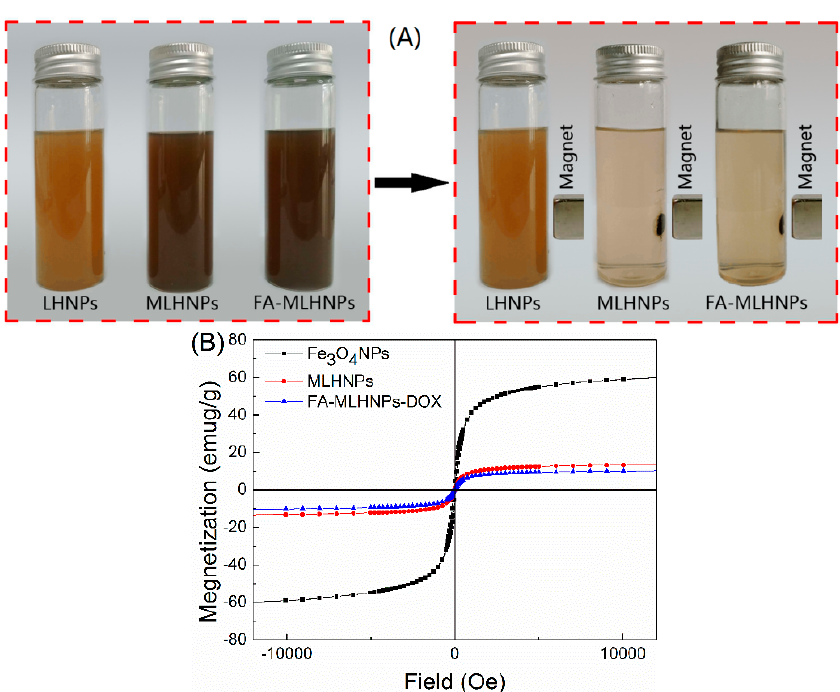
Figure 3. ( A ) The appearances of the lignin nanoparticles and the separation of the Magnetic particles with a magnet. ( B ) Magnetization curves of Fe 3 O 4 NPs, MLHNPs and FA-MLHNPs.